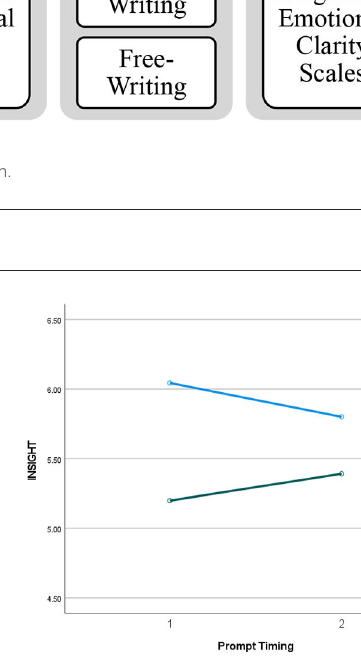
FIGURE2 Line chart comparing 2 writing conditions for levels of insight at two time points.